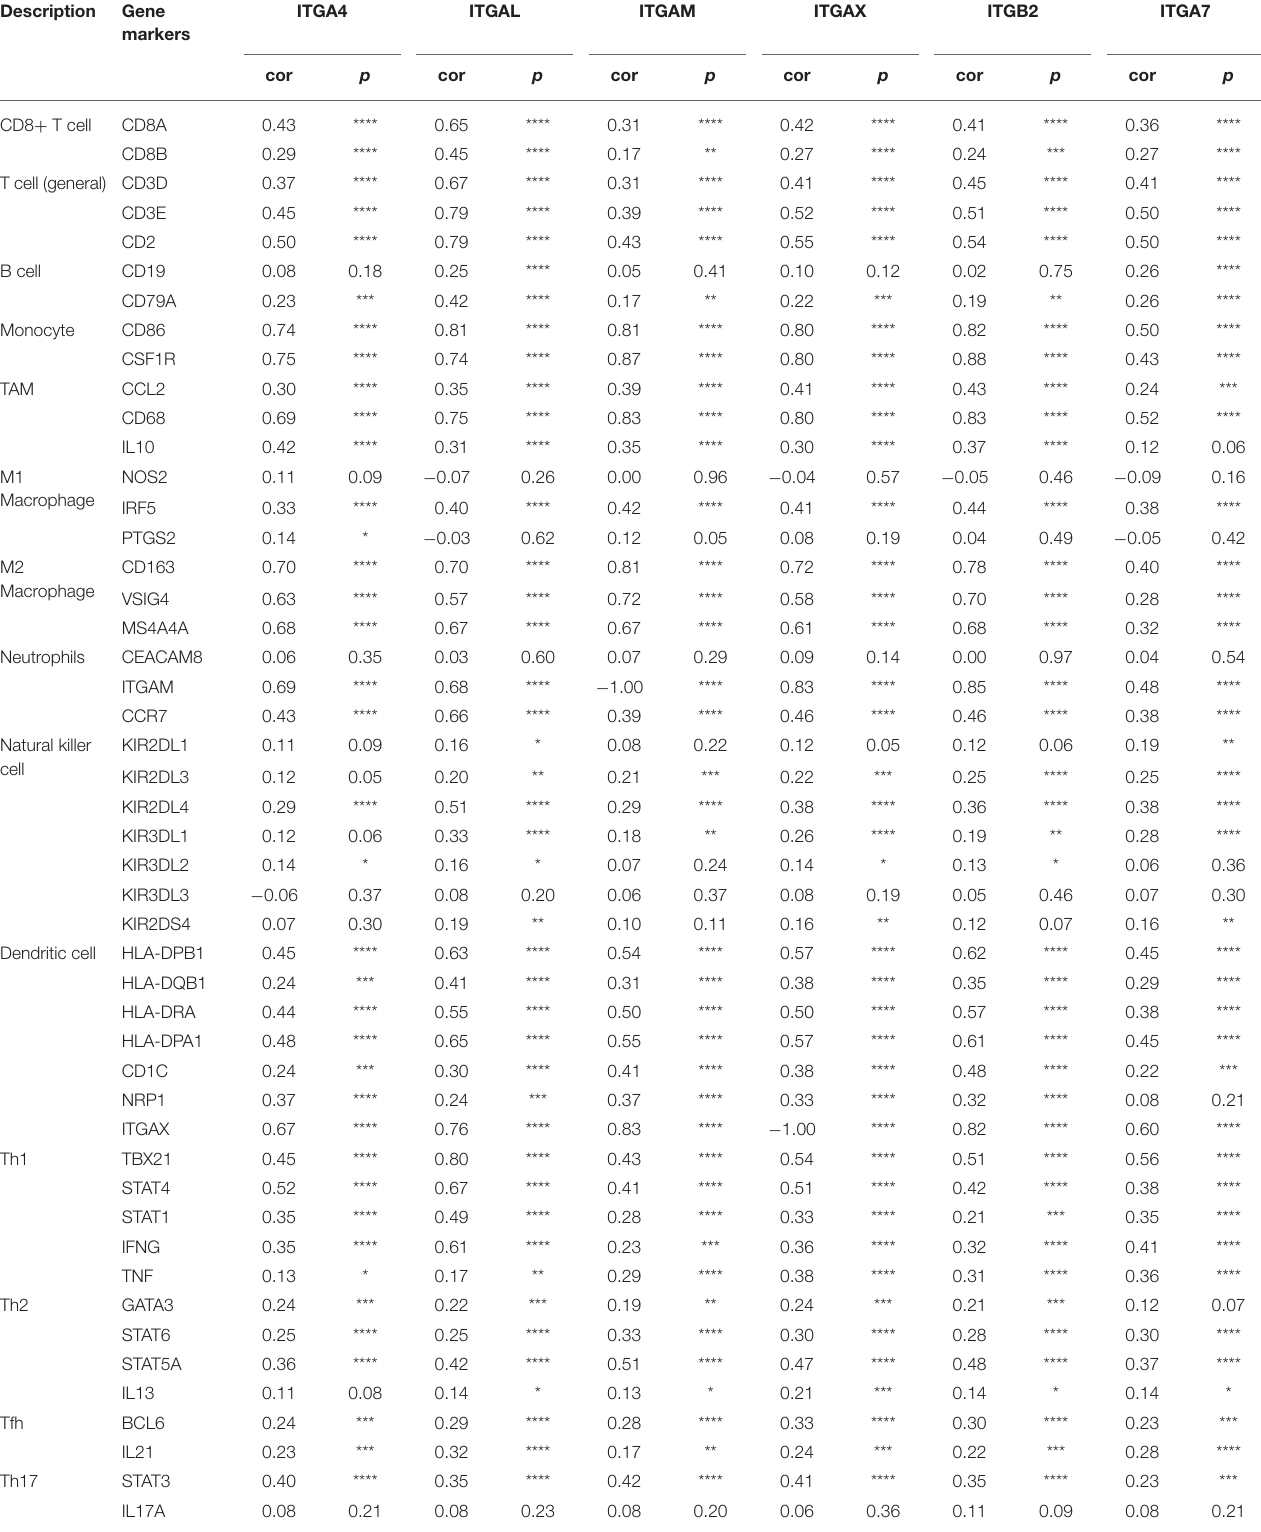
TABLE 6 | Correlation analysis between integrin genes and markers of immune cells. Description Gene markers